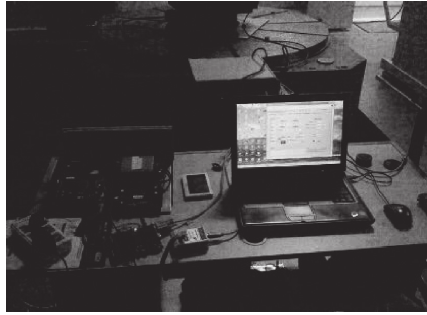
Figure 21: Initial pointing tracking experiment.